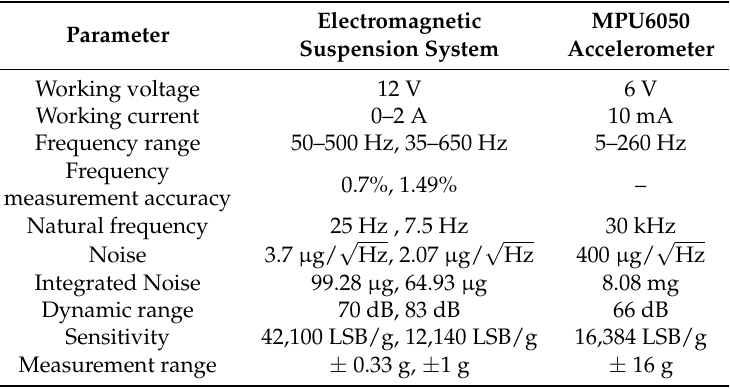
Table 2. Technical Indicators of the Maglev Measurement